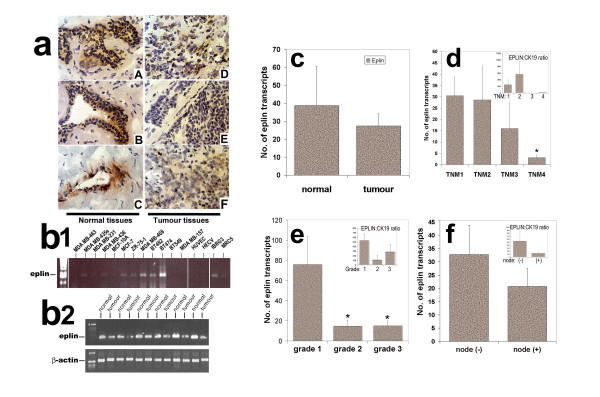
EPLIN-α expression in breast cancer tissues and cell lines.a: Immunohistochemical staining of EPLIN-α in normal mammary tissues (left panel) and tumour tissues (right panel) from different patients. The tumour tissues were from patients with different tumour grade. D was a grade-1 tumour (Patient ID 123), E a grade-2 tumour (ID 75a) and F grade-3 tumour (ID 113). Magnification was ×200 for the micrographs. b1: Detection of the EPLIN-α transcript using RT-PCR in a panel of human breast, endothelial and stromal fibroblast cell lines. b2: Detection of the EPLIN-α transcript in a panel of matched normal and tumour tissues. Actin was used as the housekeeping control. c: quantitative analysis of the EPLIN-α transcript in normal and tumour tissues. d: Levels of expression of EPLIN-α transcripts in breast tumour tissues in connection with TNM status (left; * p = 0.0029 vs TNM1 tumours). e: Levels of expression of EPLIN-α in breast tumour tissues in connection with grade (left, * p < 0.05 vs grade 1 tumours) and F: with nodal status (right). Inserts in d, e and f are values of EPLIN-α transcript that have been normalised by CK19 (shown as EPLIN:CK19 ratio).